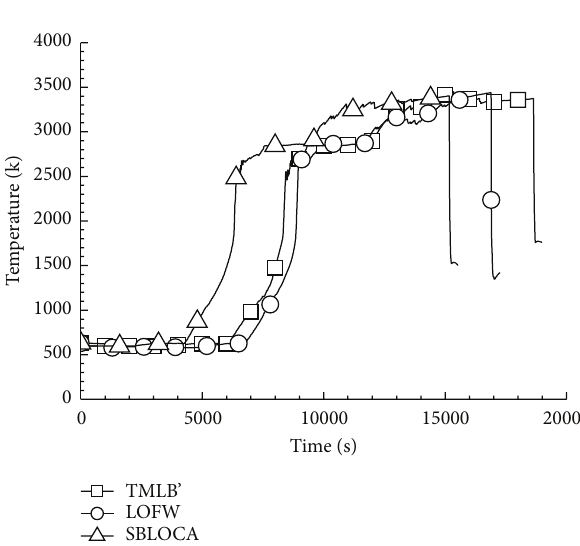
Figure 7: Flow rate through SADV with activation of SADV.